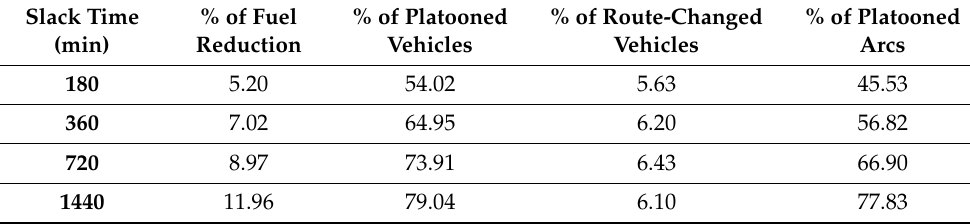
Table 9. Performance for different slack